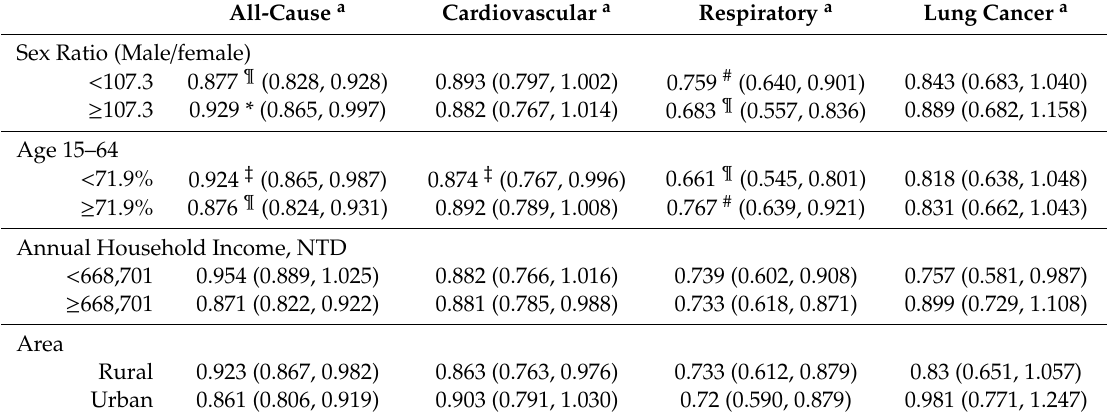
Table 3. Stratified Analysis for NDVI-Mortality Association by Population